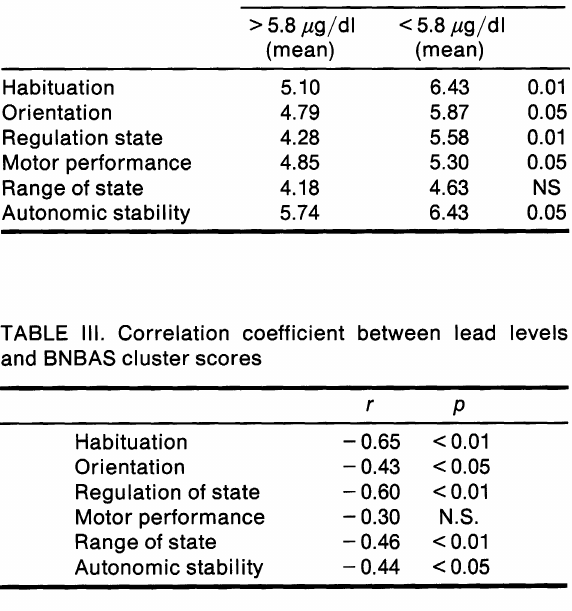
TABLE II. Comparative analysis of the BNBAS cluster mean scores of infants in the study Cord blood lead level